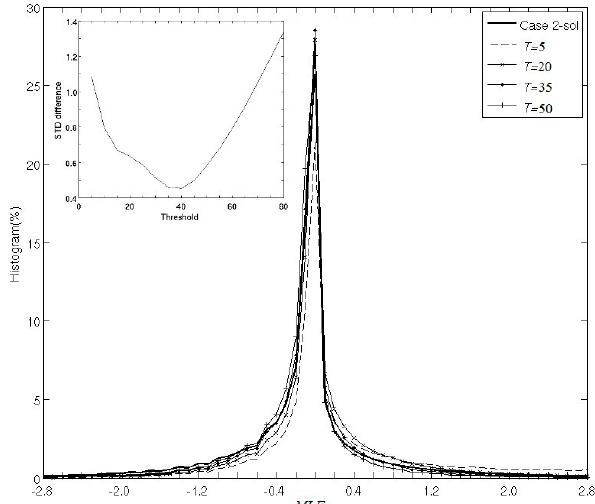
Fig. 4. Probability distribution function of the first ranked MLE at WVC number 1, for two-solution (solid line) and rejected high-rank cases with different thresholds (see legend). The standard deviation between the PDF of the two-solution cases and that of the rejected high-rank cases is illustrated as a function of the threshold in the upper left corner of this